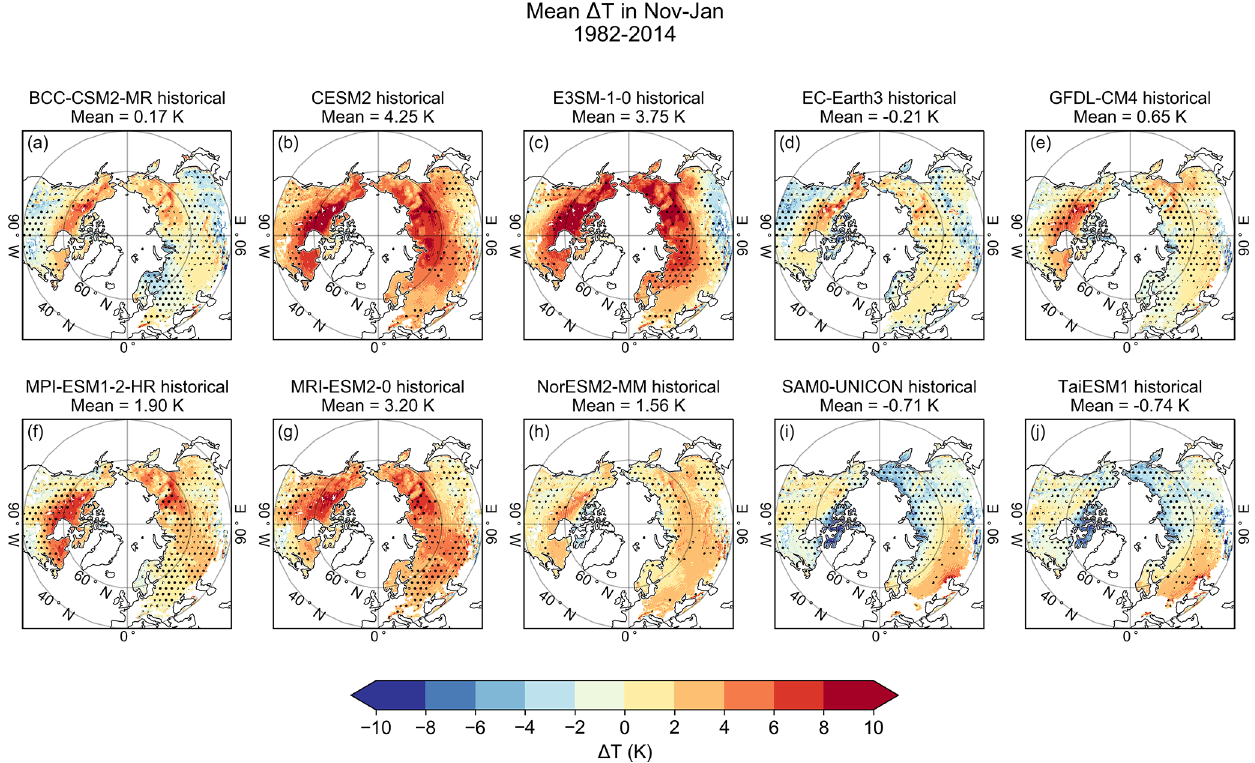
Figure 5. The mean model bias in T ( (cid:49)T , model minus observation) in snow-covered areas from November to January 1982–2014. We show (cid:49)T ( (cid:49)T cum divided by 3) instead of (cid:49)T cum so that the values are more intuitive and easier to interpret. The dots indicate areas with either cold bias and positive SWE bias or warm bias and negative SWE bias, i.e., the areas where T bias could logically explain the SWE